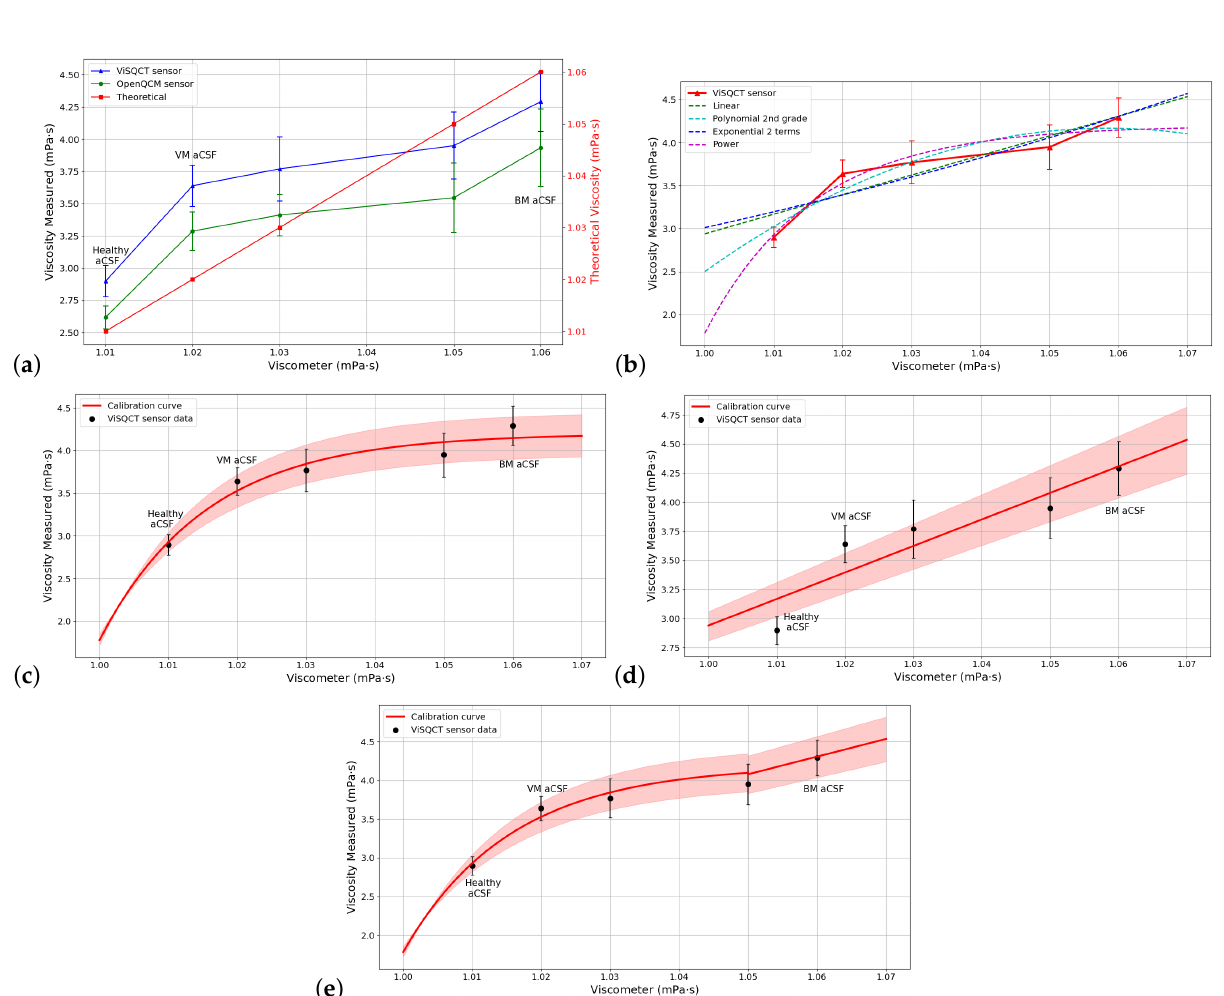
Figure 7. ( a ) Comparison of measured viscosities for aCSF using the two sensors and the rotational viscometer. ( b ) Adjustment with different functions for aCSF. ( c ) Power function adjustment for aCSF. ( d ) Linear adjustment for aCSF. ( e ) Calibration curve using a function defined by parts for aCSF.